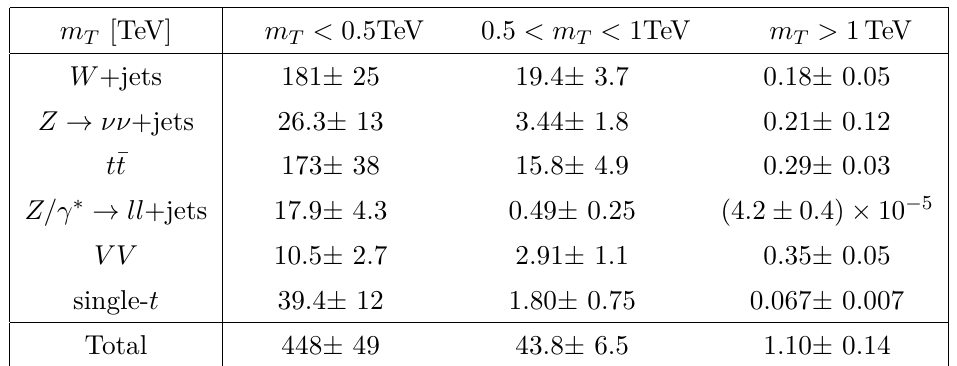
√ s =13 TeV and an